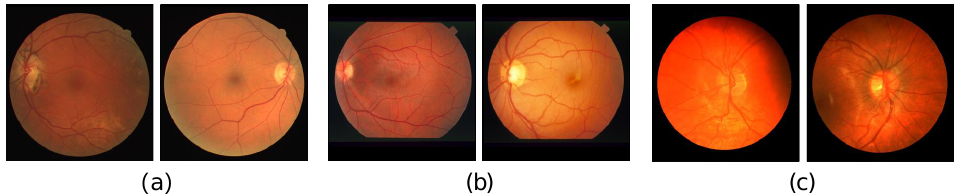
Figure 1. Examples of some images in the three datasets; ( a ) is the DRIVE dataset, ( b ) is the STARE dataset, and ( c ) is the CHASE